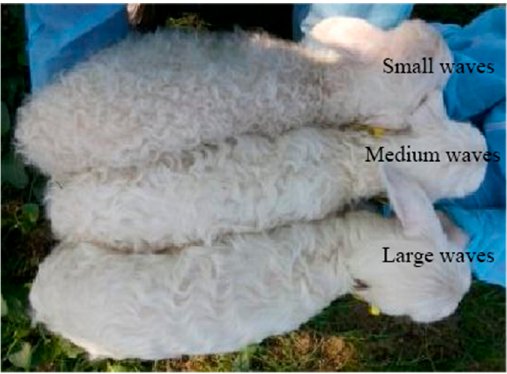
Figure 1. The different patterns of lambskin of Hu